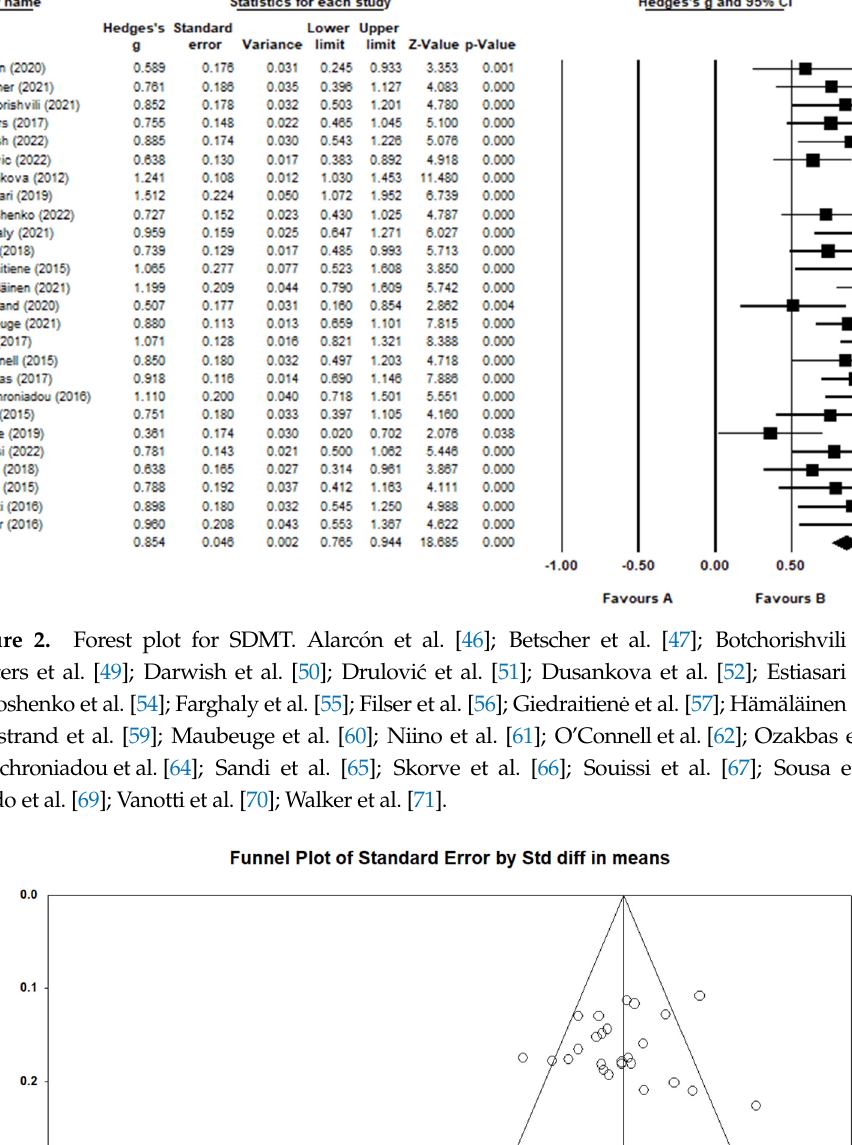
Figure 3. Funnel plot for SDMT .